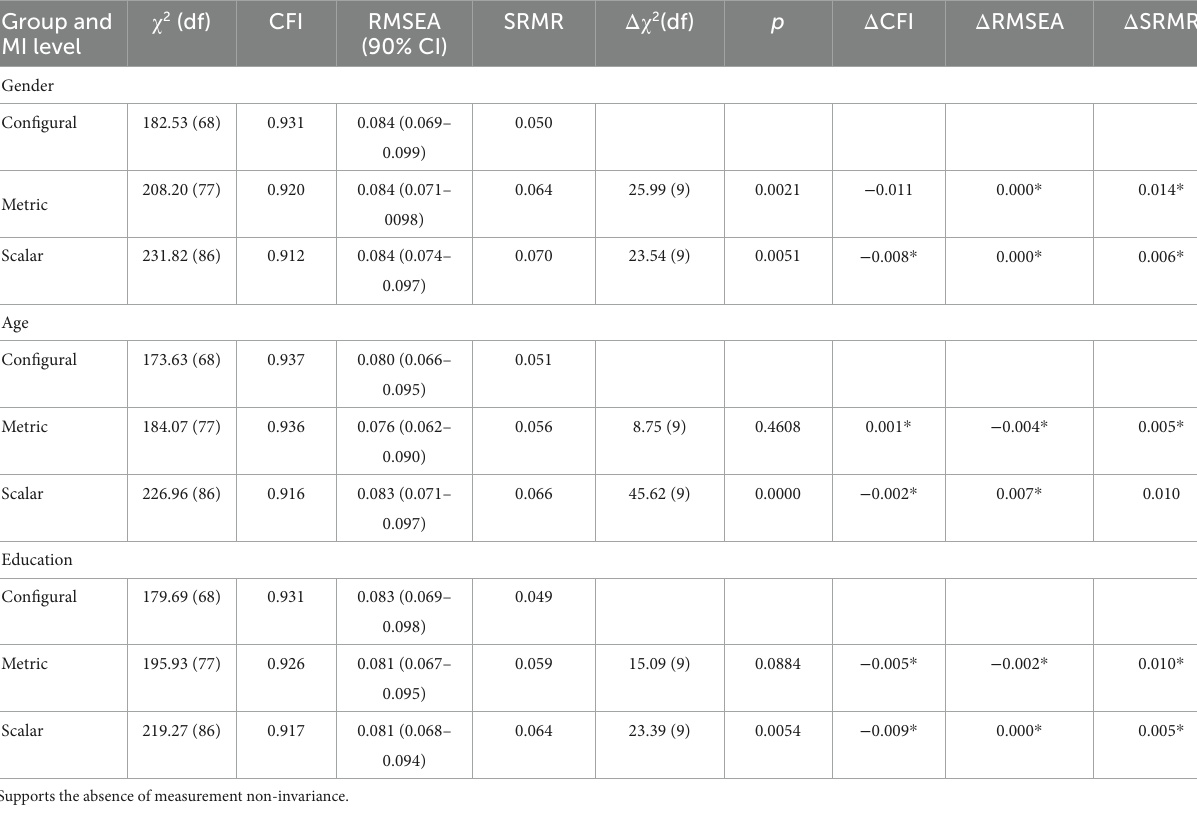
TABLE 4 Measurement invariance between gender, age and educational level on the GSAAS. Group and MI level